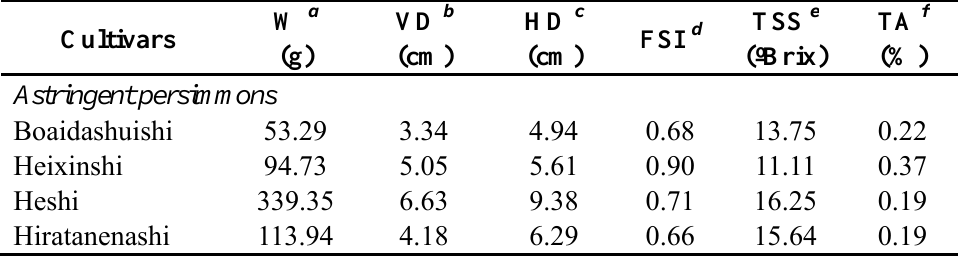
Table 1. Main Fruit Quality Index of Persimmon